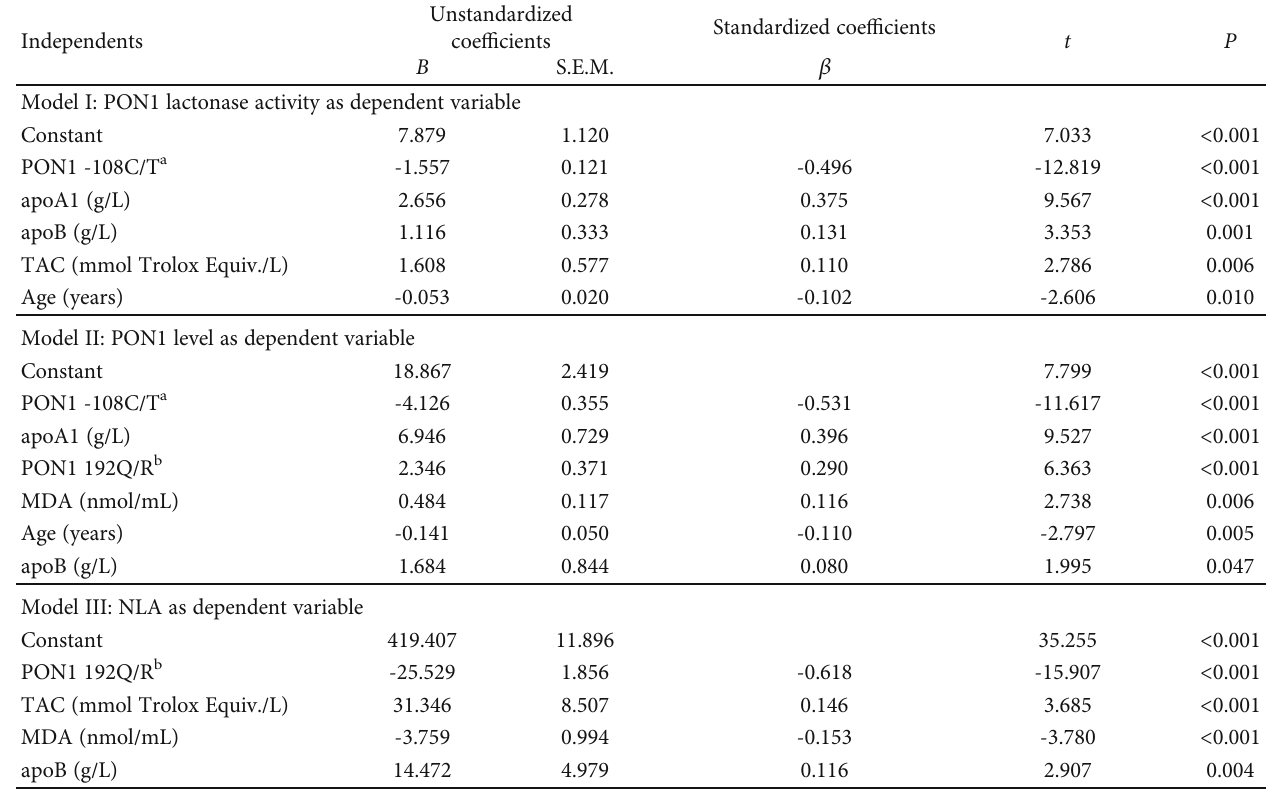
Table 5: Association of important independent variables with lactonase activity, level, and NLA of PON1 by multivariate regression analysis in the women with and without GDM.